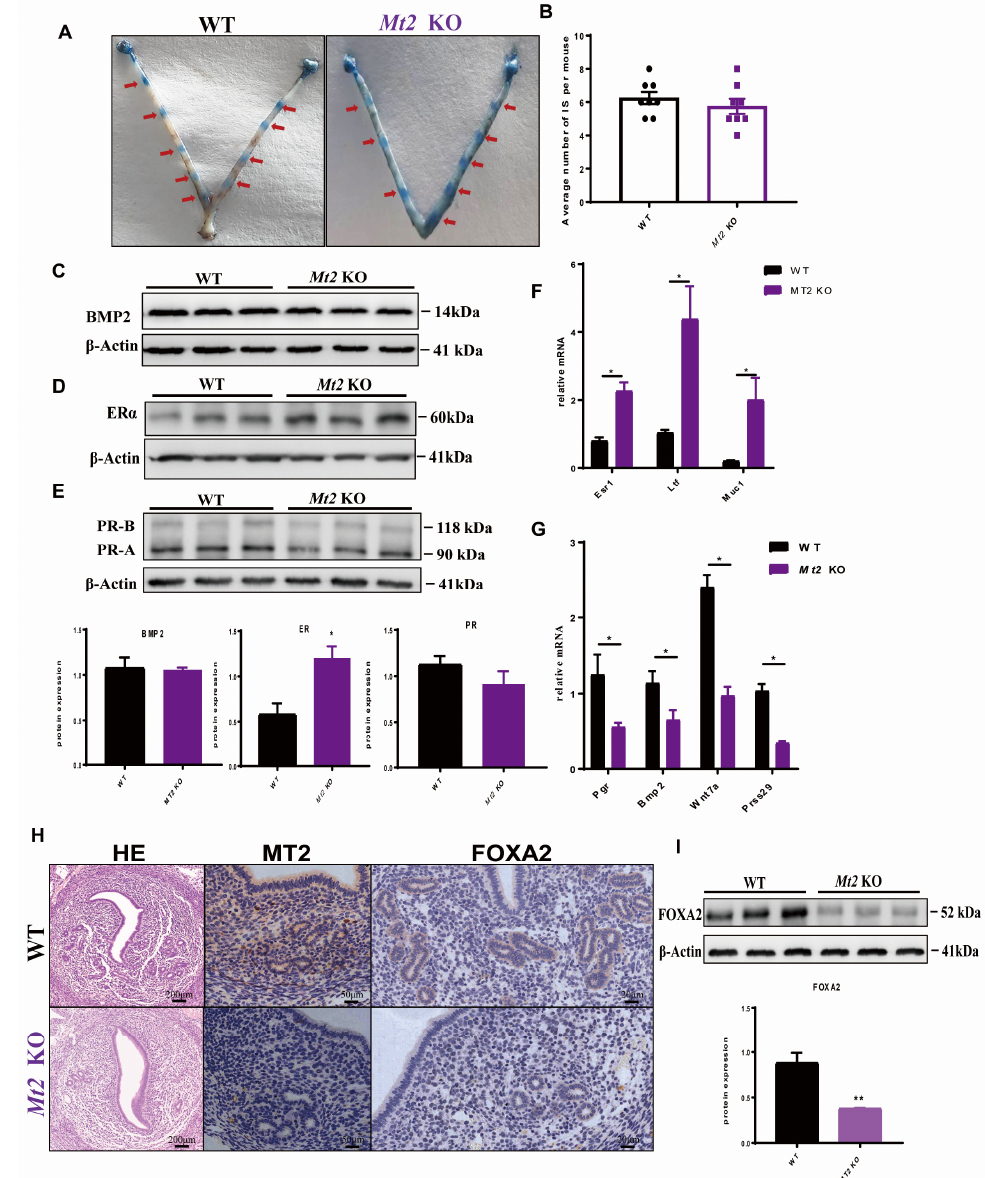
Figure 4. Effects of Mt2 KO on the uterine estrogen and progesterone response and uterine glands formation during the implantation window. ( A , B ) Implantation sites during the implantation window with statistical analysis. As the red arrows indicate, the blue is the attachment sites displayed after Chicago Sky Blue staining. ( C ) Expression of the BMP2 protein. ( D ) Expression of the ER α protein with statistical analysis. ( E ) Expression of the PR-A protein with statistical analysis. ( F , G ) Quantitative PCR analysis of estrogen and progesterone response-related genes. ( H ) HE staining of the uteri at 4.5 day of pregnancy; immunohistochemical staining of the uterus in 4.5 dpc mice; the brown staining is MT2 and the blue staining is the nucleus. ( I ) Expression of FOXA2 with statistical analysis, n = 3. Note: * p < 0.05, ** p < 0.01.